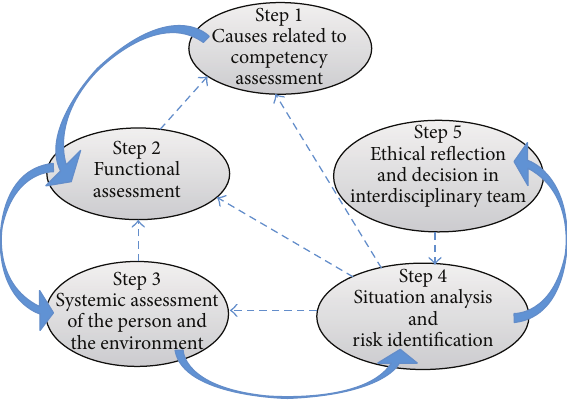
Figure 1: Competency Assessment Process, Giroux